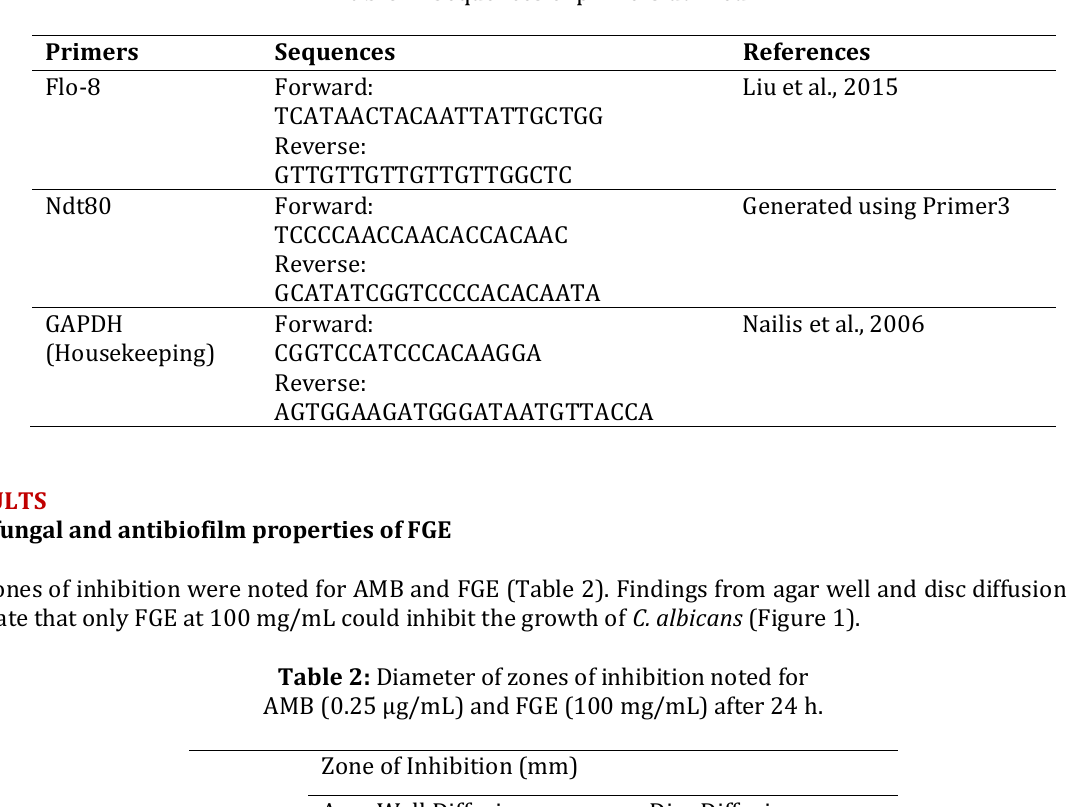
Table 1: Sequences of primers utilized.